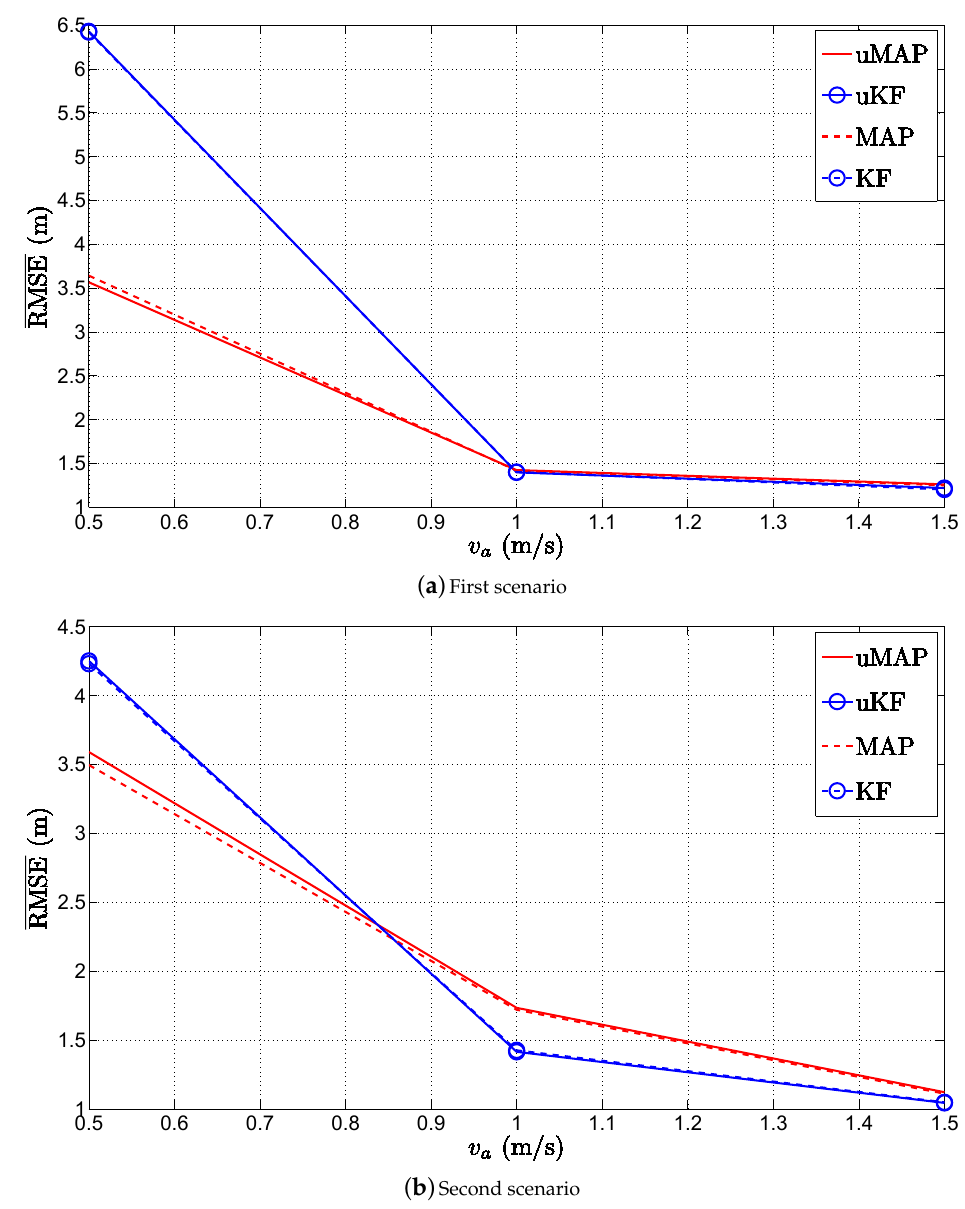
= 9 dB, σ m = 4 π rad, 180 i i